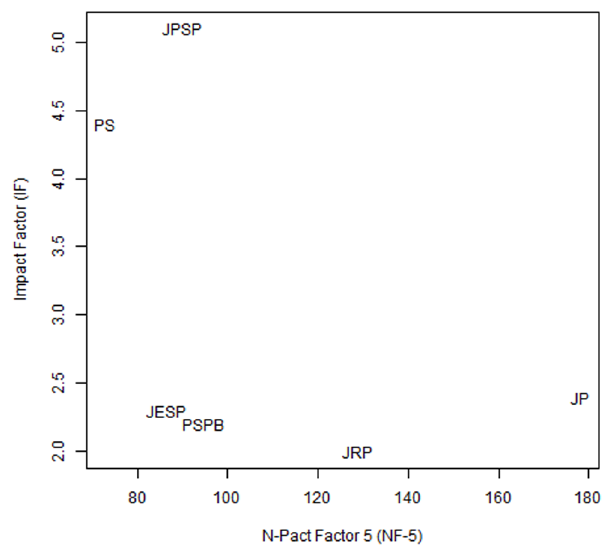
Figure 2. Journals plotted in a two-dimensional space defined by their 5-year N-Pact Factors (NF-5) and their citation Impact Factors.